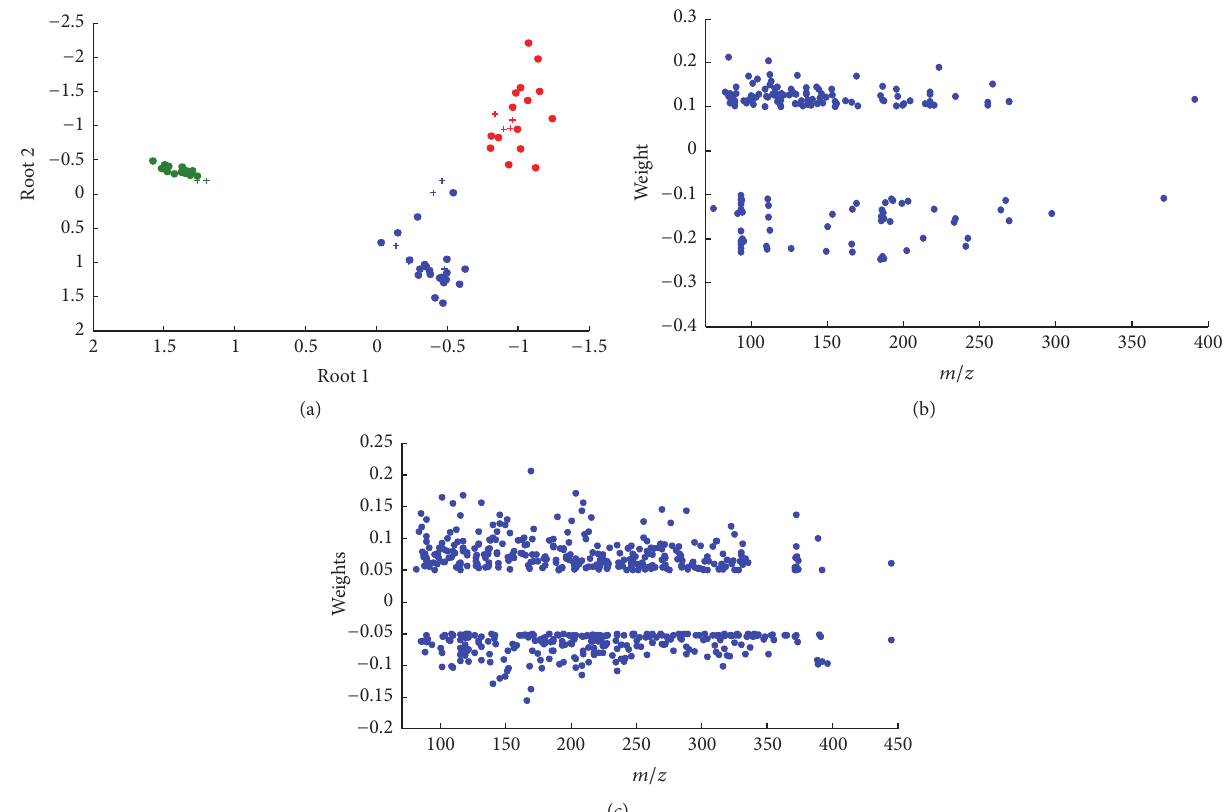
Figure 7: Results of canonical analysis: canonical scores of Root 1 and Root 2 (a). The samples are separated along the two roots in the three classes: untreated parchment sample (red), the parchment sample treated with castor oil (blue), and the parchment sample treated with glycerol (green). Circles represent samples from the training set while crosses represent samples from the test set. (b) and (c) represent the weights of the original variables on Root 1 and Root 2, respectively: original variables are reported on the 𝑥 -axis and the weights on the 𝑦 -axis. Only the most significant weights are reported (identified by normal probability plots).